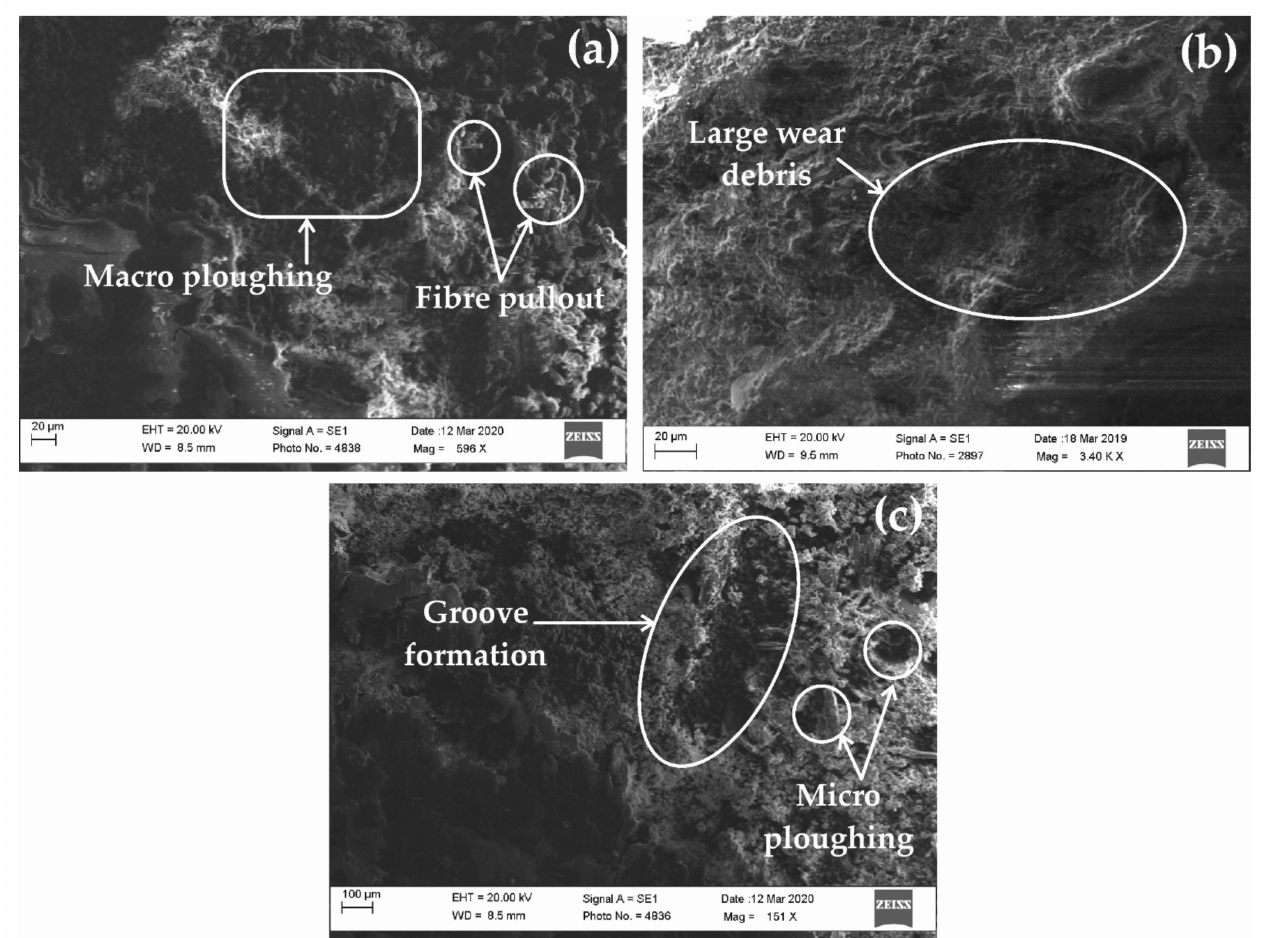
Figure 10. SEM images at highest fiber loading ( a ) epoxy based composite, ( b ) vinyl ester and ( c ) polyester based